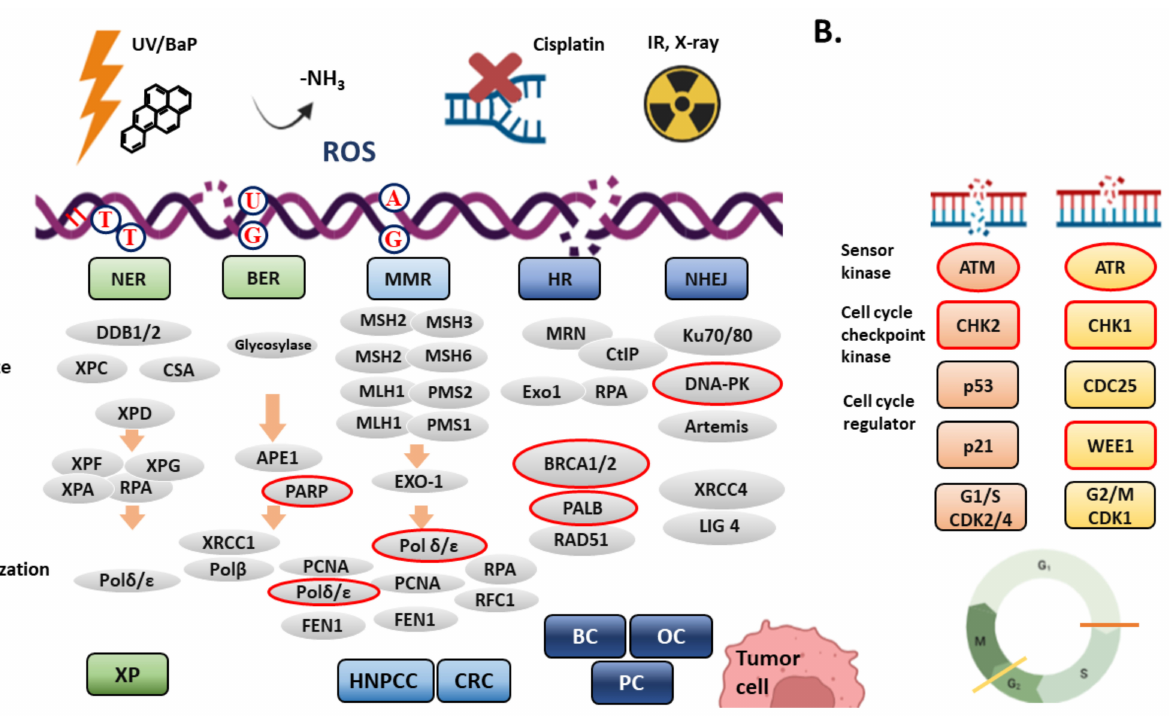
Figure 2. ( A ) DNA repair systems. Different DNA damages are recognized and repaired through different DNA repair pathways. DNA damages shown here includes ultraviolent light